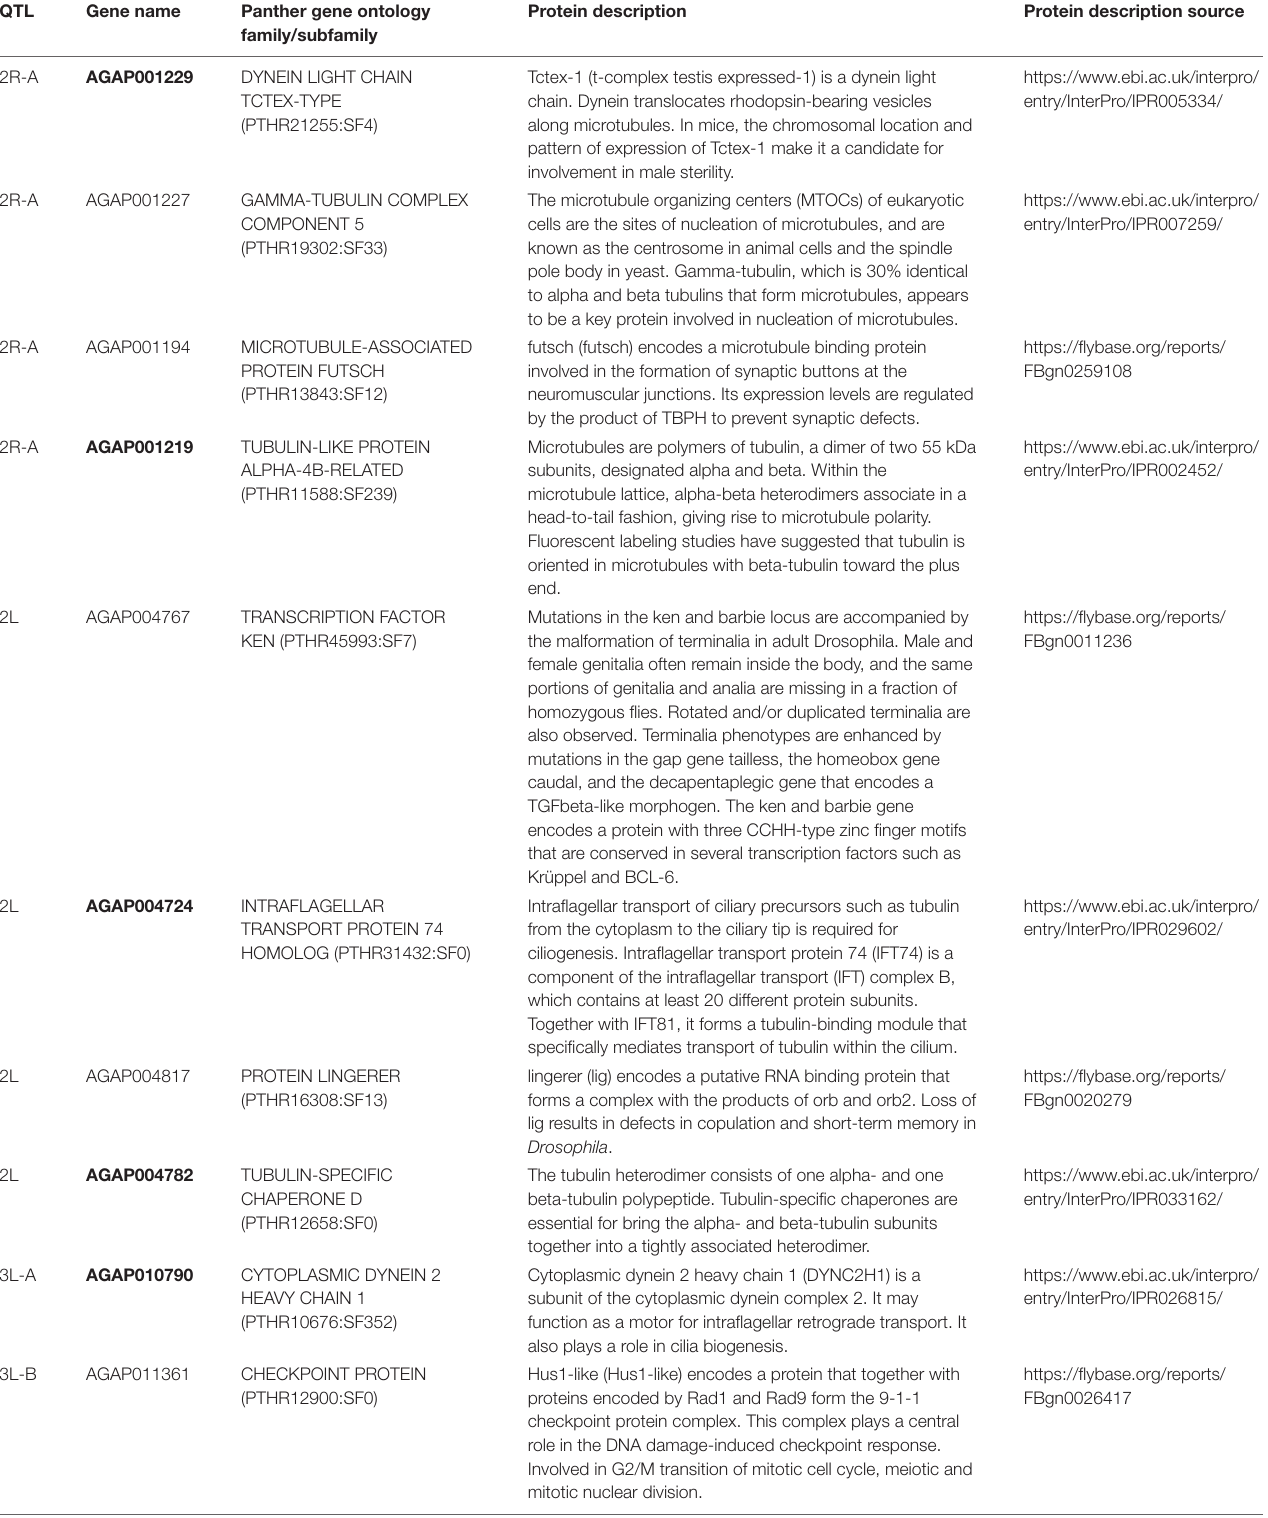
Gene names in bold indicate those interacting in a regulatory network associated with sperm microtubule morphogenesis and function. STRING network analysis output can be found in Supplementary File 1 : Deitz_et_al_2020_String_protein_interaction_network.xlsx.